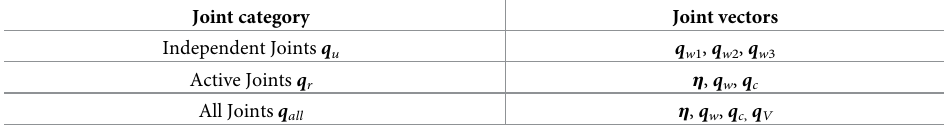
Table 1. S/N major categories and vectors of joints used in